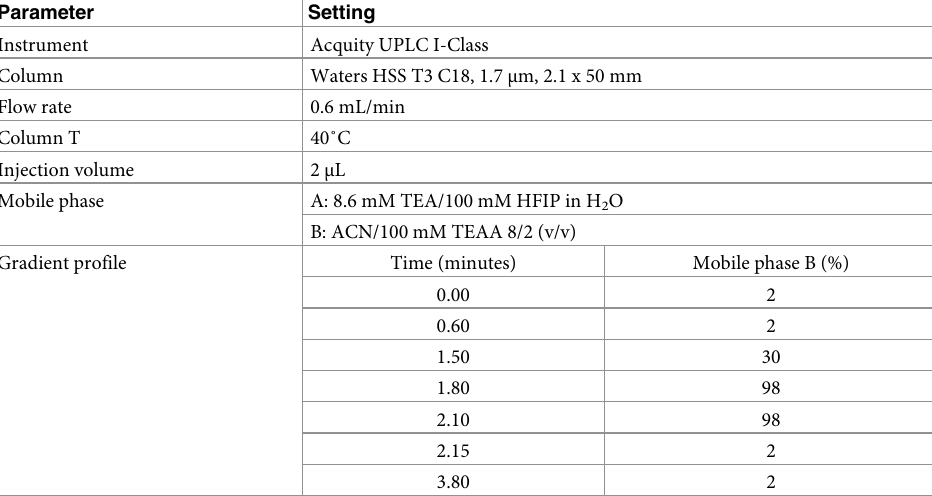
Table 1. Chromatographic conditions for analysis of free CoA (CoASH) and acetylCoA (unlabelled, +4 and +6 AMU) in brain extracts. Parameter